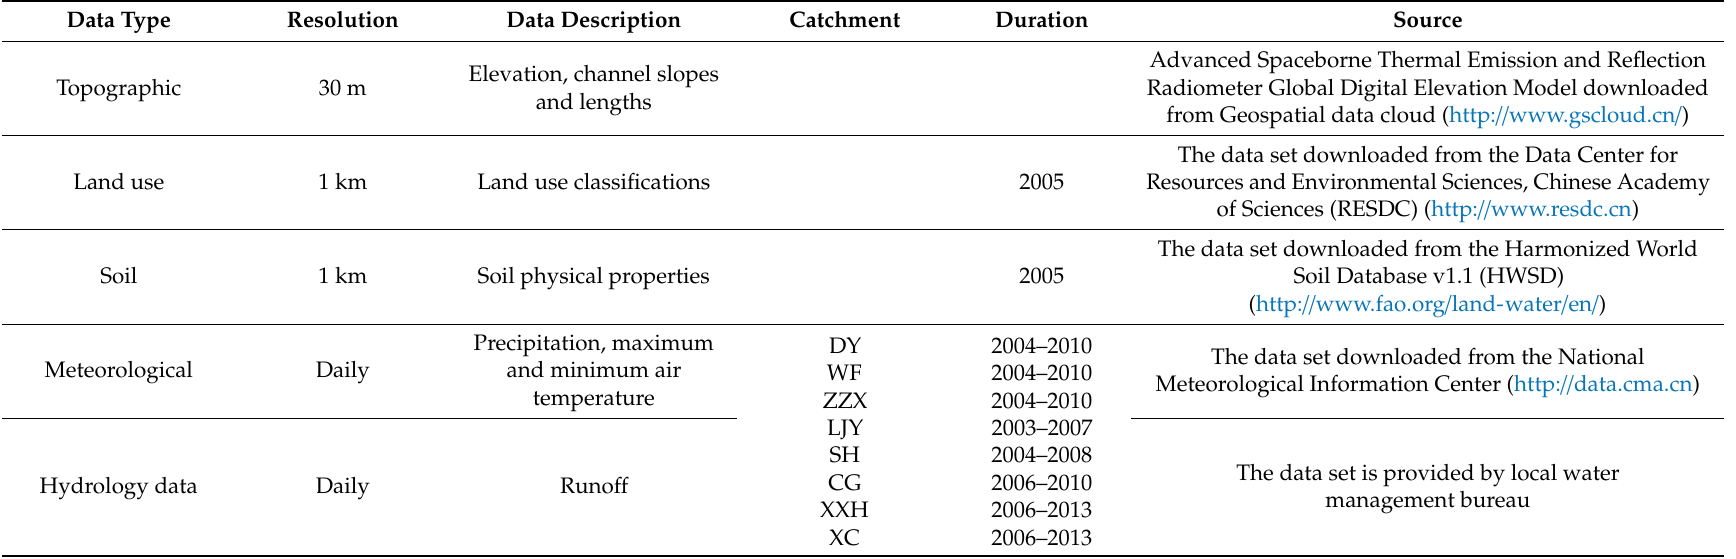
Table 2. Description of the data